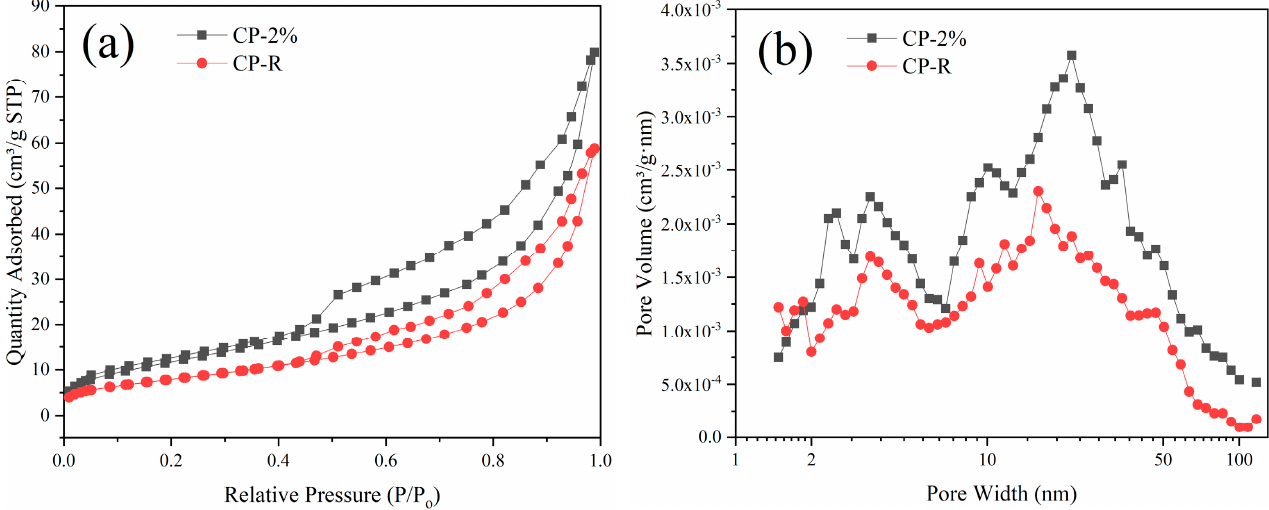
Figure 4. ( a ) Specific surface area and ( b ) pore size distribution of the CP-R and CP-2% paste samples after curing for 28 days.